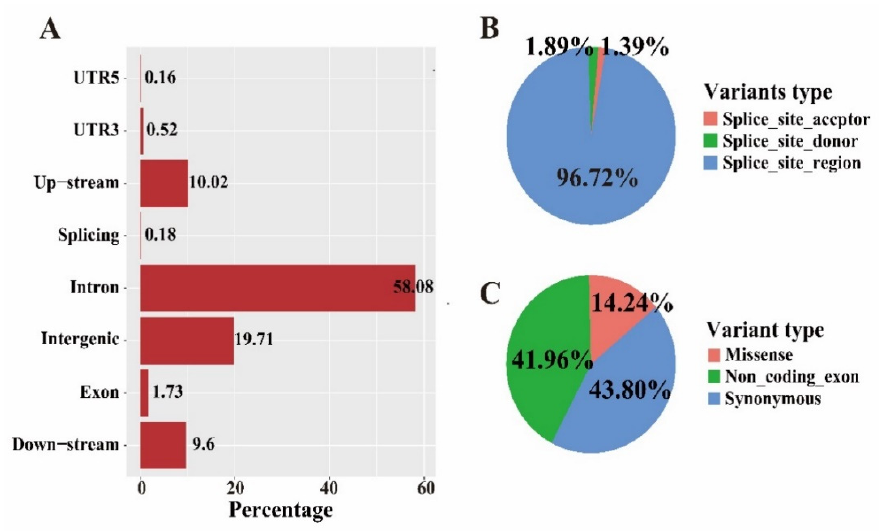
Figure 1. SNP characteristics of JX chicken. ( A ) Distribution of genetic variations within various function regions. ( B , C ) Ratio of different variants in splicing site and exon region,